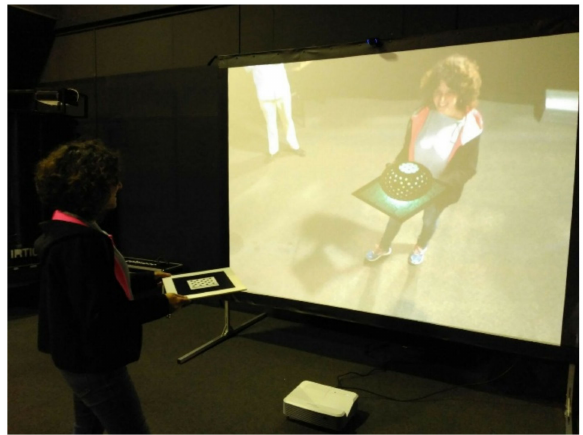
Figure 3. Laboratory setup of the TinajAR system, at the IRTIC laboratory of the University of Valencia, Spain.